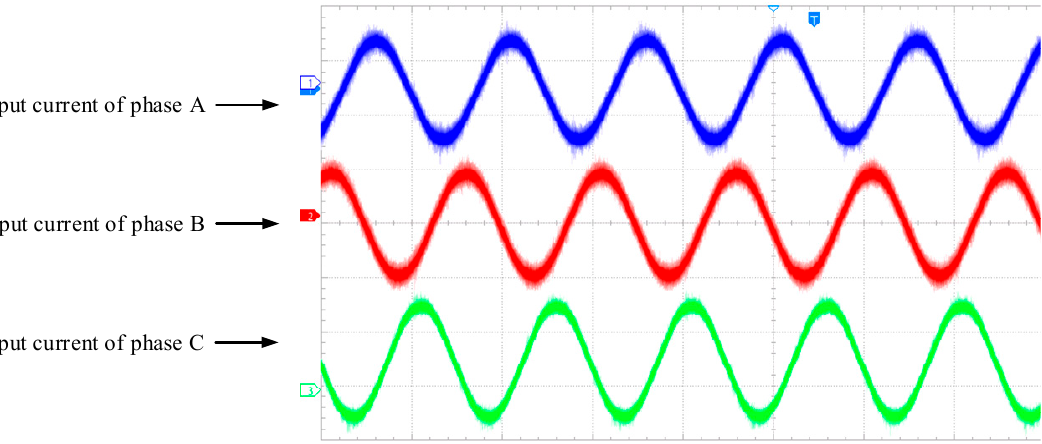
Figure 12. Waveform of output current of three phases of MMC.